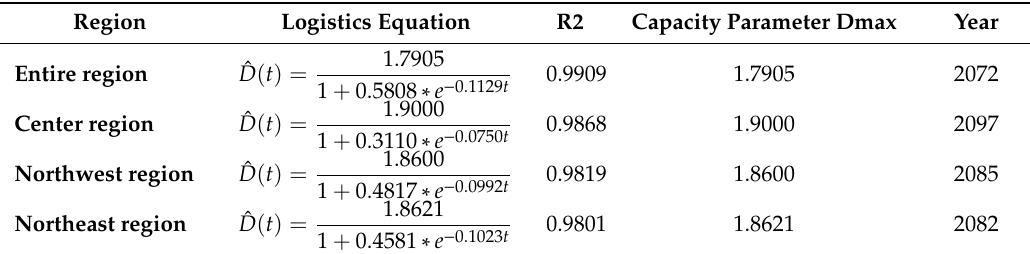
Table 2. Four regions logistics equation information table in Shenzhen, 1986–2017. Region Logistics Equation R2 Capacity Parameter Dmax Entire region ˆ D ( t )